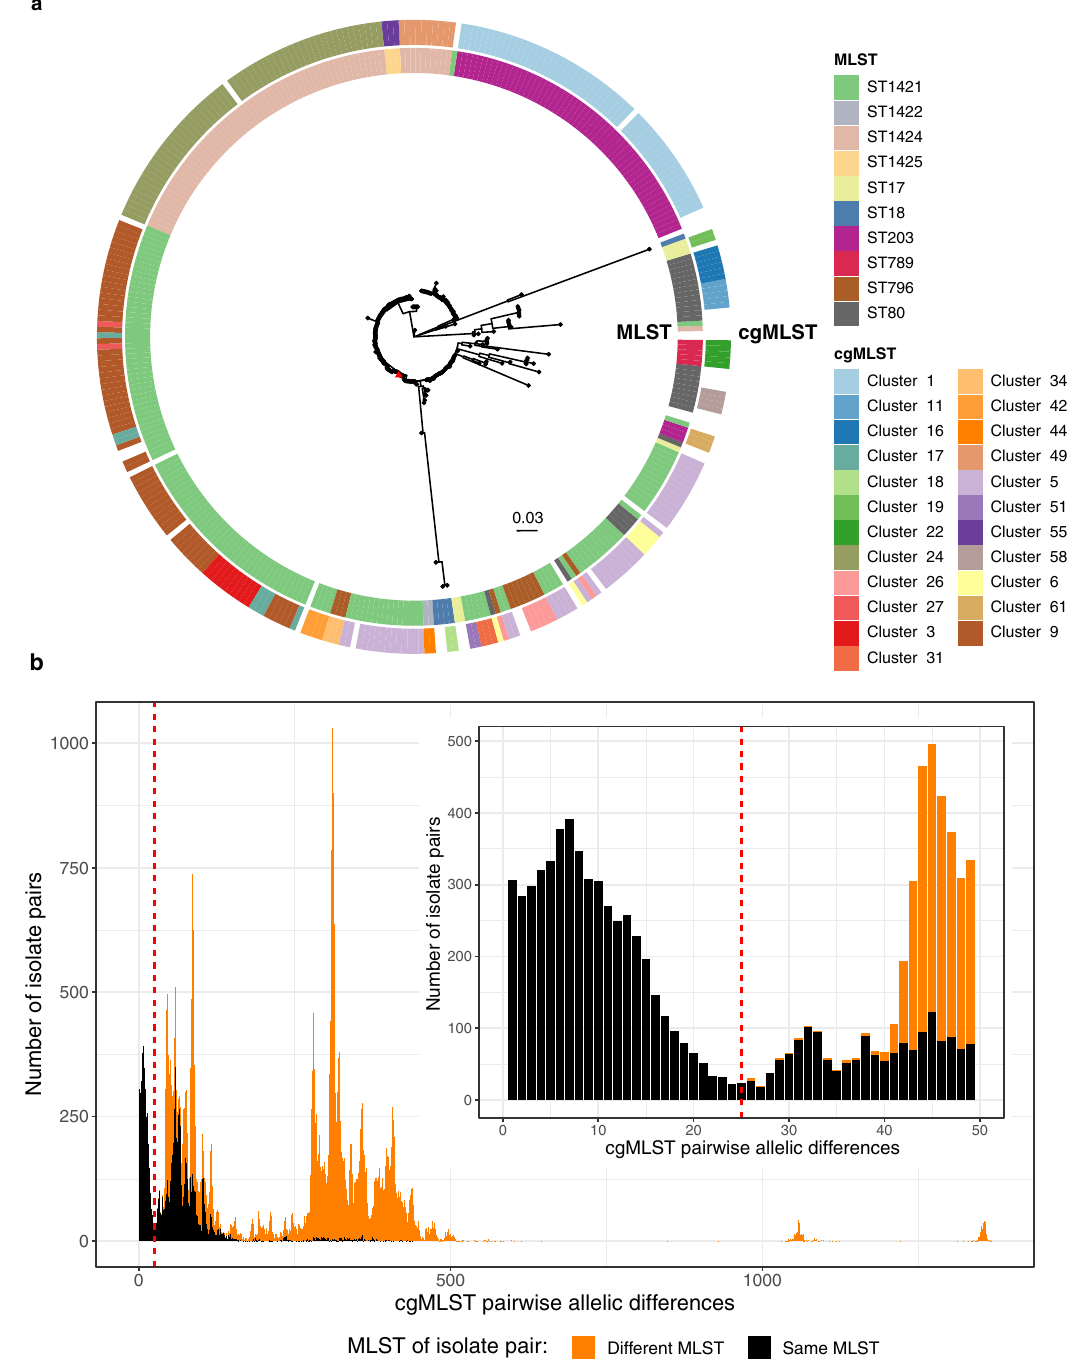
Fig. 1 Comparison of genomic typing methods for E faecium. a Midpoint-rooted maximum-likelihood phylogenetic tree of E. faecium isolates. Tree includes all isolates used in this study not including genetic outliers ( n = 343). The reference genome is identi fi ed by the red triangle tip and is sequence type (ST) 1421. Singleton STs and core genome multilocus sequence type (cgMLST) clusters with only one isolate are shown in white. b Stacked histogram of cgMLST allelic differences between all E. faecium isolate pairs ( n = 346 isolates). The total number of genes in the scheme is 1423. The red dashed line represents a pairwise allelic difference threshold of 25. The inset graph shows the same data set but has been restricted to show only cgMLST pairwise allelic difference of ≤